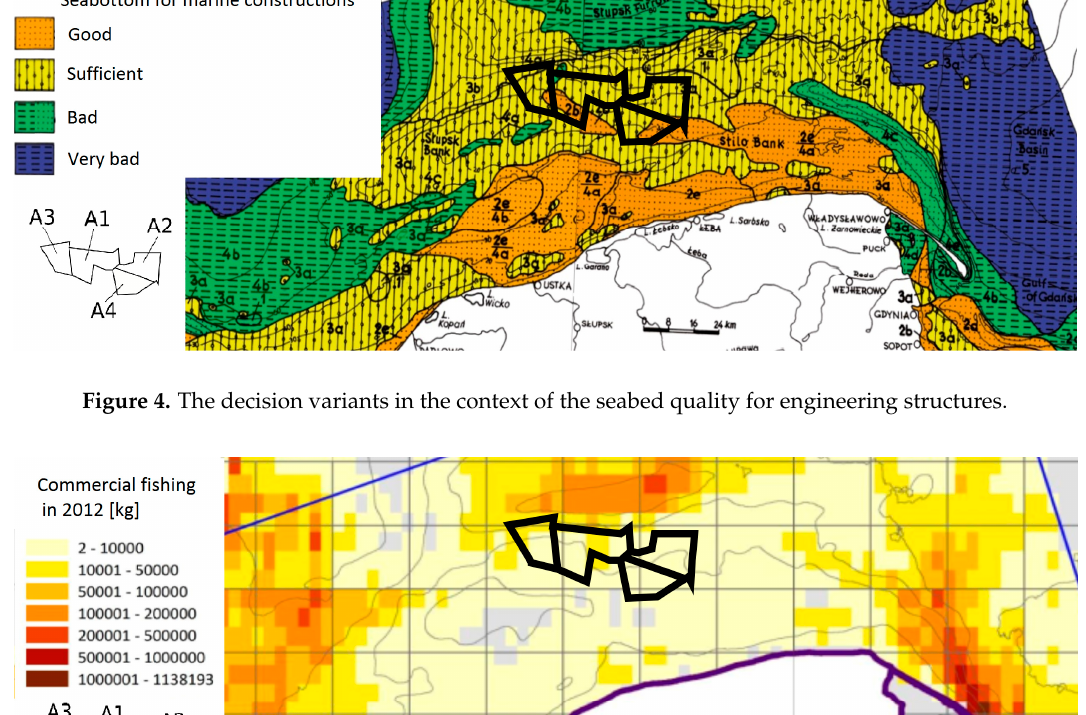
Figure 3. Decision variants and other areas for the construction of offshore wind farms in the Polish economic zone in the Baltic Sea.